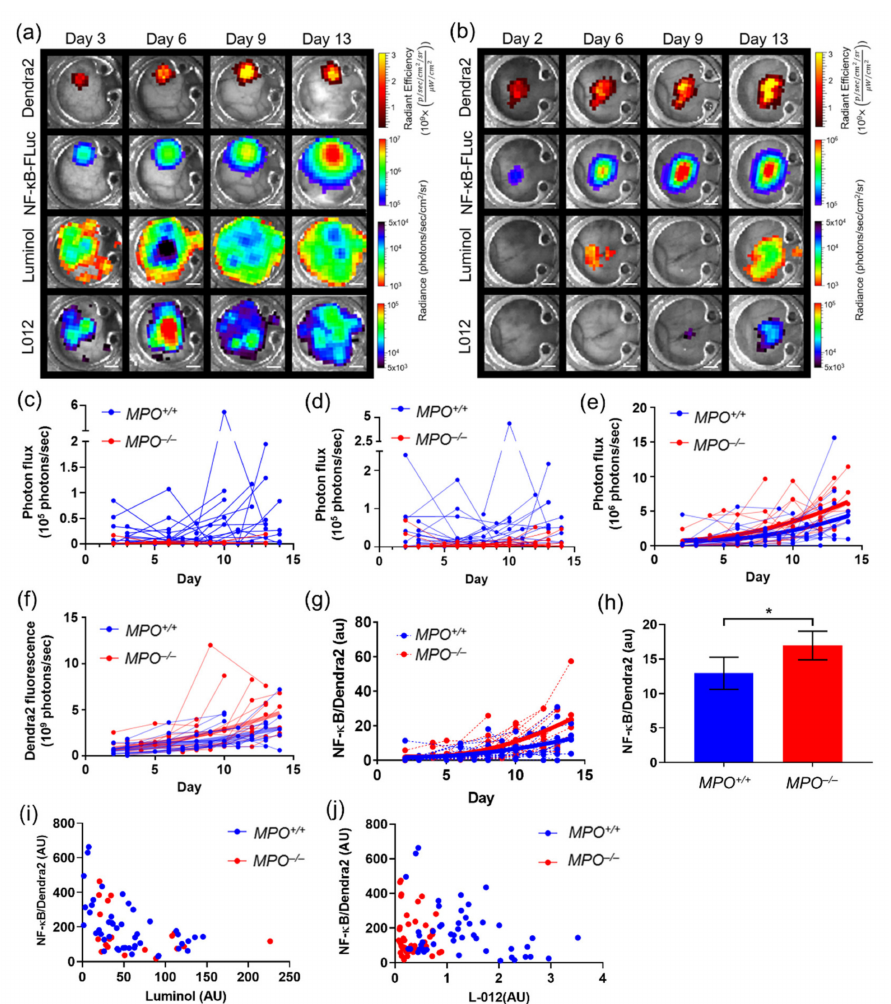
Figure 2. In vivo bioluminescence unmixing and quantification of different reporters in window chamber-bearing wild type ( MPO +/+ ) and syngeneic MPO-null ( MPO − / − ) animals. Representative unmixed in vivo window chamber macro-imaging over time of B16F10 NF- κ B-FLuc Dendra2 tumor growth in ( a ) MPO +/+ and ( b ) MPO − / − animals ( n = 17 MPO +/+ animals, n = 16 MPO − / − animals). B16F10 tumor cells imaged using Dendra2 fluorescence ( λ ex = 409 nm, λ em = 507 nm) and tumor NF- κ B transcriptional activation monitored by FLuc bioluminescence following D-luciferin injection. Innate immune cell infiltration imaged using luminol and L-012; scale bar represents 2 mm. Window chamber longitudinal bioluminescence quantification as a function of time of ( c ) luminol and ( d ) L-012 in MPO +/+ (blue) and MPO − / − (red) animals (each line represents a different animal). Quantification of ( e ) tumor NF- κ B transcriptional activation as a function of time in individual animals (second-order polynomial non-linear regression with significantly different curve fits for MPO +/+ versus MPO − / − data sets, P < 0.05, modified from previously reported publication [42]), ( f ) tumor Dendra2 fluorescence over time in each individual animal (second-order polynomial non-linear regression with significantly different curve fits for MPO +/+ versus MPO − / − data sets, p < 0.05, modified from previously reported publication [42]), and ( g ) NF- κ B transcriptional activation normalized to tumor mass as a function of time in individual animals (second-order polynomial non-linear regression with significantly different curve fits for MPO +/+ versus MPO − / − data sets, p < 0.0006, modified from previously reported publication [42]). ( h ) Time-averaged mean of NF- κ B transcriptional activation normalized to tumor mass using Dendra2 fluorescence in MPO +/+ vs. MPO − / − animals (statistical significance calculated by identifying outliers, unpaired two-tailed Mann–Whitney t test, * p < 0.05, modified from previously reported publication [42]). Correlation of NF- κ B tumor transcriptional activation and ( i ) luminol and ( j ) L-012 bioluminescence of MPO +/+ (blue) and MPO − / − (red) animals (modified from previously reported publication